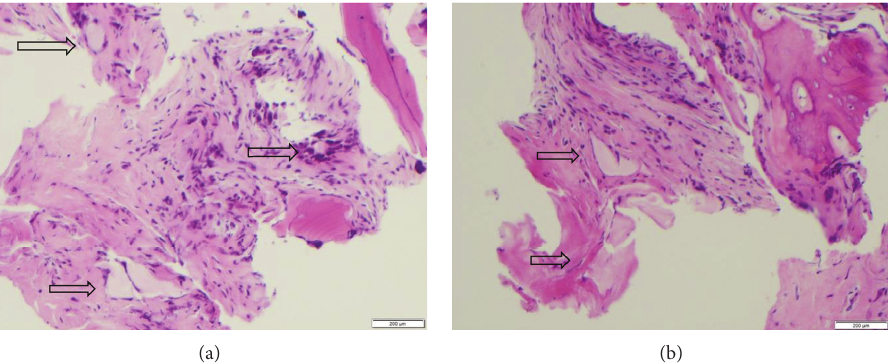
Figure 4: (a, b) Biopsy from right L5-S1 facet joint demonstrating large amorphous deposits (arrows) surrounded by granulomatous inflammation and foreign body giant cells, consistent with spinal